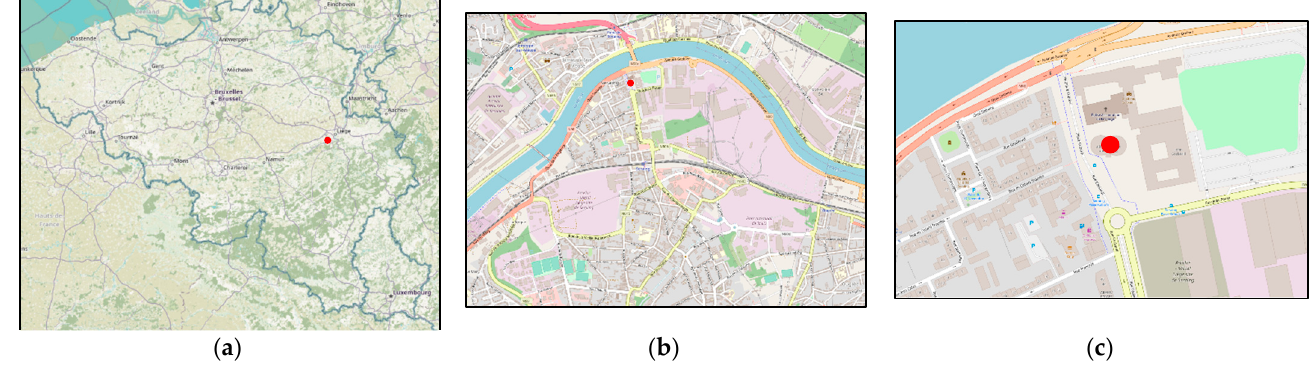
Figure 2. Location of the experimental site: ( a ) Map of Belgium with Seraing in red; ( b ) map of Seraing; ( c ) Seraing administrative city. Map data © OpenStreetMap contributors, CC BY-SA 2.0.